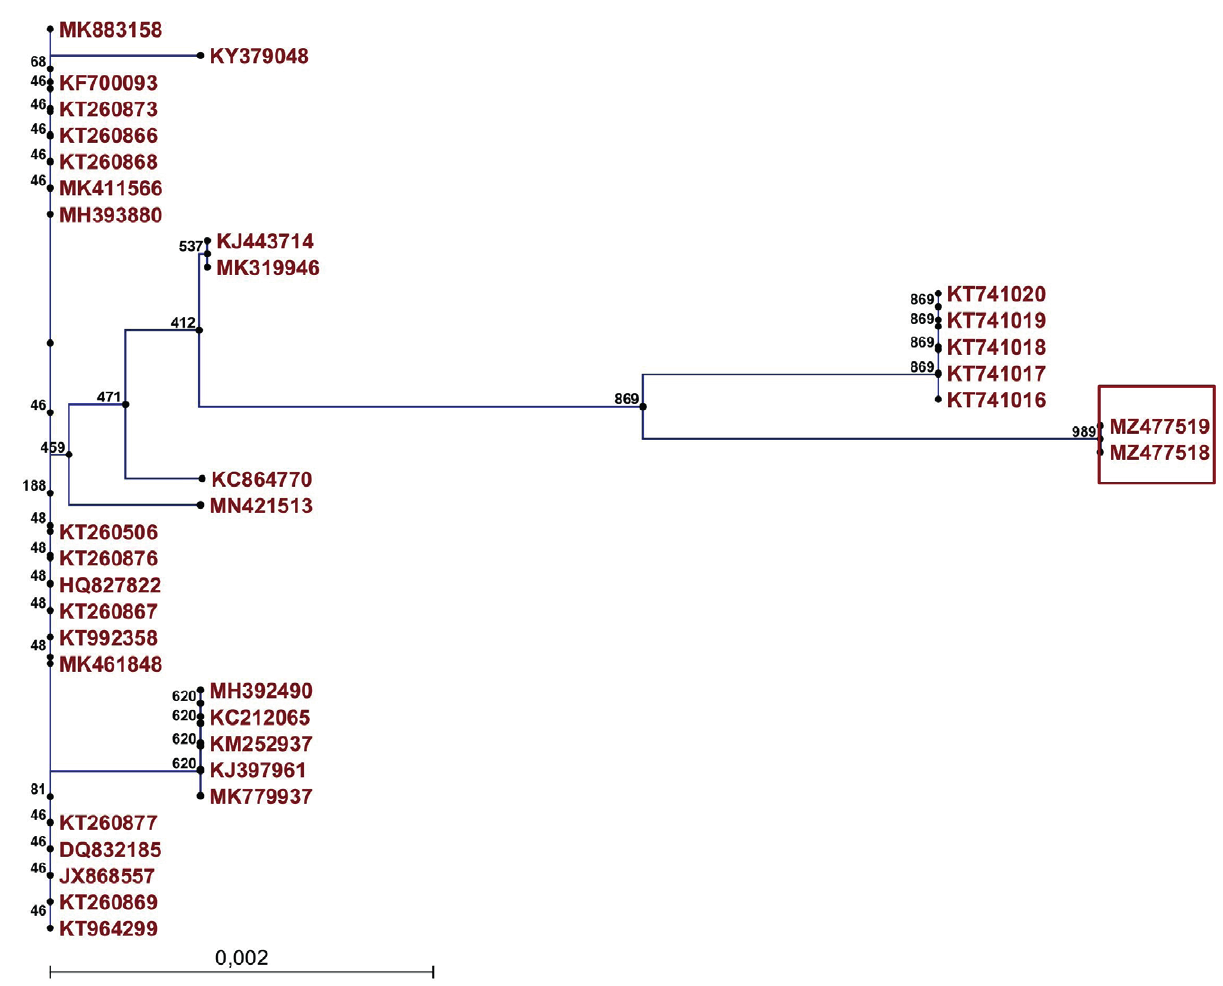
Figure 4. Phylogenetic tree of Serratia marcescens isolates, based on the 16S rRAS gene sequences. The tree was generated using the Neigh- bor-Joining method. GenBank accession numbers are shown. Hungarian S. marcescens isolates MZ477519 and MZ477518 are indicated with